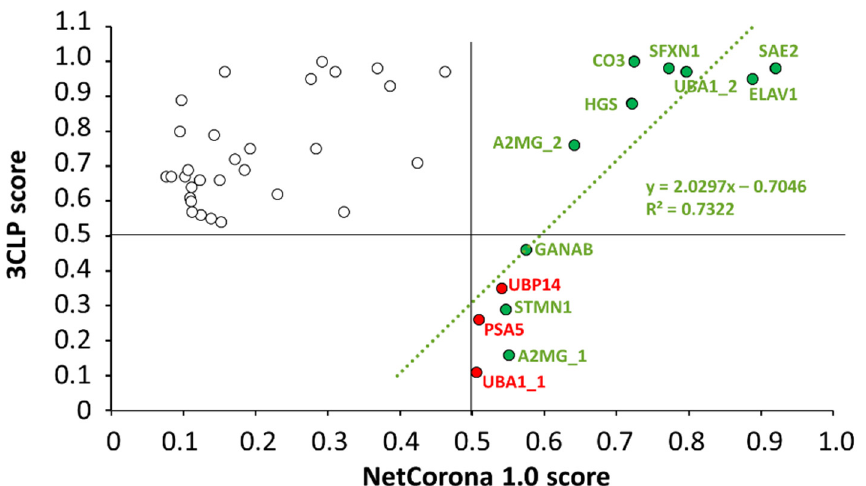
Figure 7. Linear regression analysis of the NetCorona and 3CLP scores. The scores are shown for sequences that were predicted to be cleavage sites either by NetCorona or 3CLP (empty circles). The numerical values are shown in Table 1. The default cutoff of both NetCorona and 3CLP is 0.5, and >0.5 values (max. score is 1.0) imply possible cleavage at the given positions. The higher the score, the higher the cleavage probability. A regression line (green) was fitted to the data points of cleavage sites for which we observed cleavage in vitro (green circles). Sites that were not cleaved in vitro were omitted from the regression analysis (red circles). Data points of potential cleavage sites predicted by both methods are in the upper right quarter.